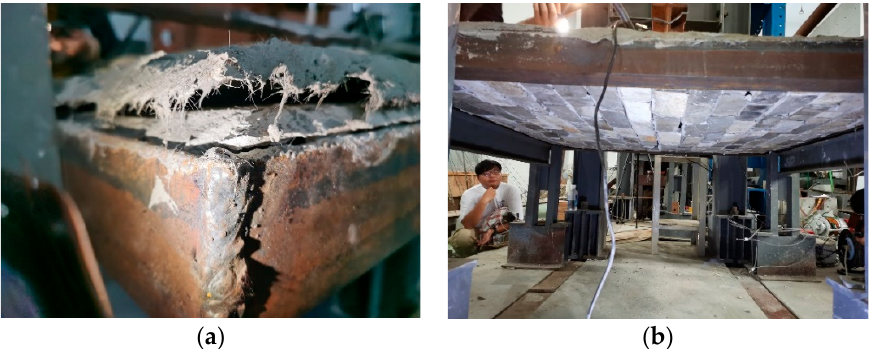
Figure 10. Ductile damage of specimen HDC1. ( a ) Corner buckling; ( b ) downward deflection in the middle of the wall.